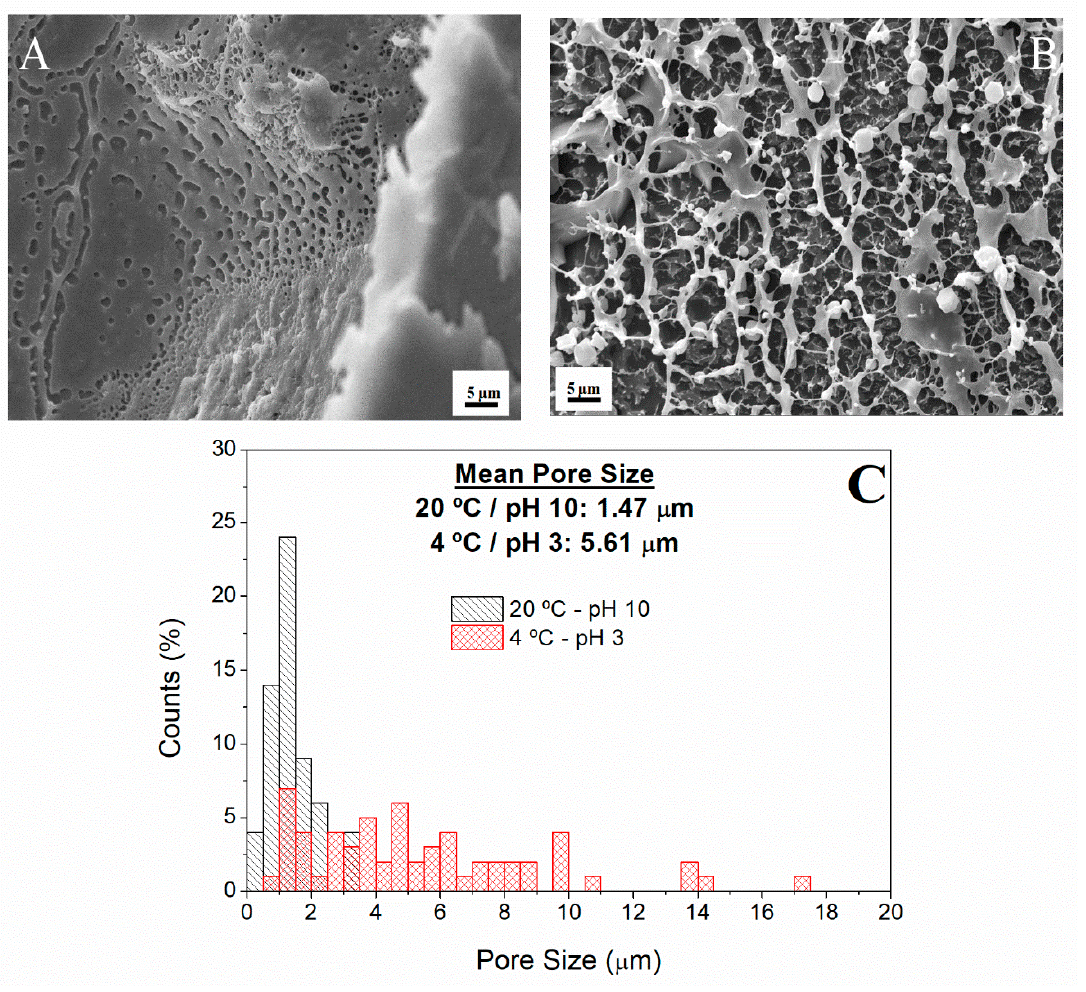
Figure 5. Cryo-SEM images of the hydrogels studied: ( A ) pH 10 at 20 °C; ( B ) pH 3 at 4 °C and ( C) pore size distribution of both hydrogels produced with the selected conditions.